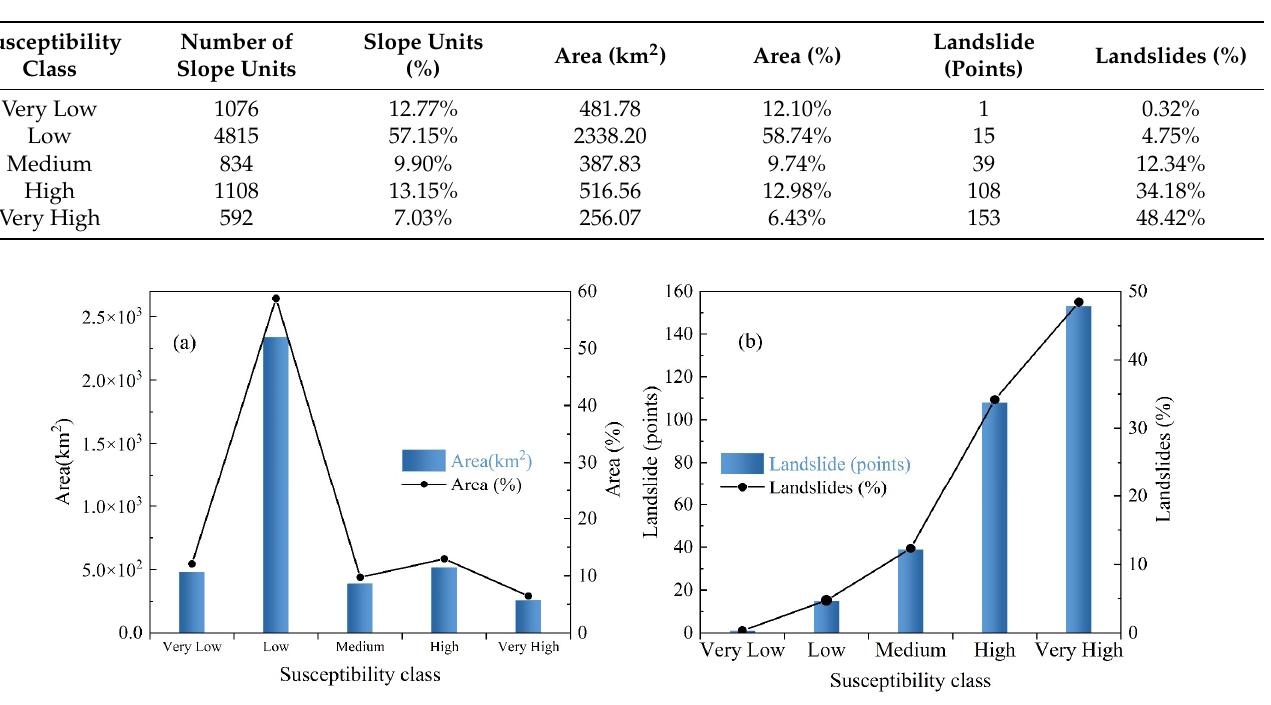
Table 3. Statistics of Different Susceptibility Areas.